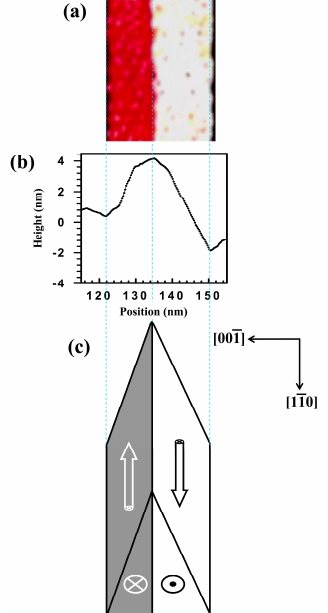
Figure 6. ( a ) The SP-d I / d V map and ( b ) the cross-sectional profile of the triangular-sectional NW E. ( c ) Schematic sketch of the proposed magnetization configurations in the triangular-sectional NW E.